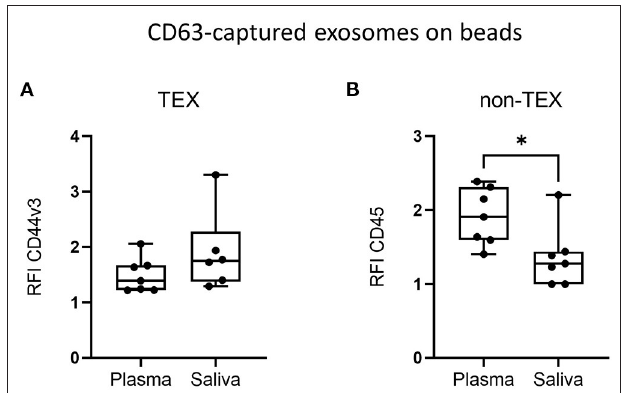
FIGURE 4 | Tumor-derived exosomes (TEX) and non-TEX amounts in total exosome populations from saliva. Exosomes isolated from plasma and saliva of HD and HNSCC patients (n = 7) were stained for (A) CD44v3 (TEX) and (B) CD45 (non-TEX) using bead-based flow cytometry. Surface levels are shown as RFI compared to isotype controls. Saliva had significantly lower amounts of CD45 + exosomes compared to plasma (B) . Results are plotted as box-and-whisker blots representing the median value, the 25 th and 75 th quartiles and the range. P-values were determined by Mann–Whitney test, * p ≤